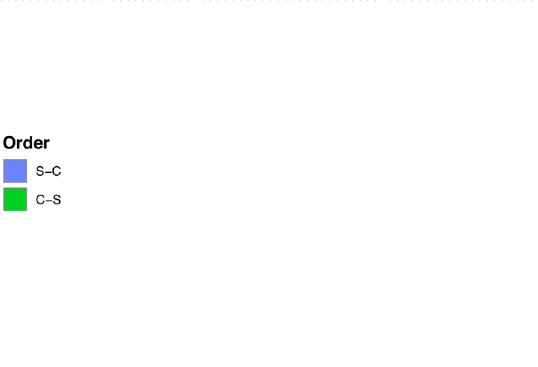
Figure 5. Temporal generalization gradients of Experiment 2 (linearly spaced ratios) by presentation order. Proportion of “equal” responses for the Sub-Second (left) and Supra-Second (right) conditions by presentation order. Vertical lines represent 95% confidence levels.